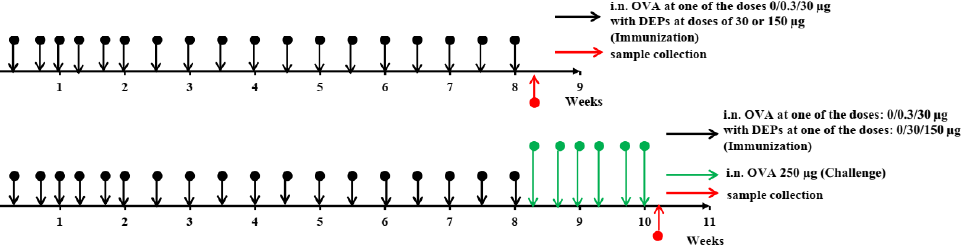
Figure 1. Study design. Black arrows indicate i.n. immunization of mice with OVA alone at a 0.3 µ g or 30 µ g dose or in combination with DEPs at a low (30 µ g) or high (150 µ g) dose. Animals immunized with saline alone without OVA were used as a control group. Green arrows indicate a high-dose (250 µg) OVA i.n. challenge. The time points when the mice were killed and when the samples were collected are indicated by red arrows.